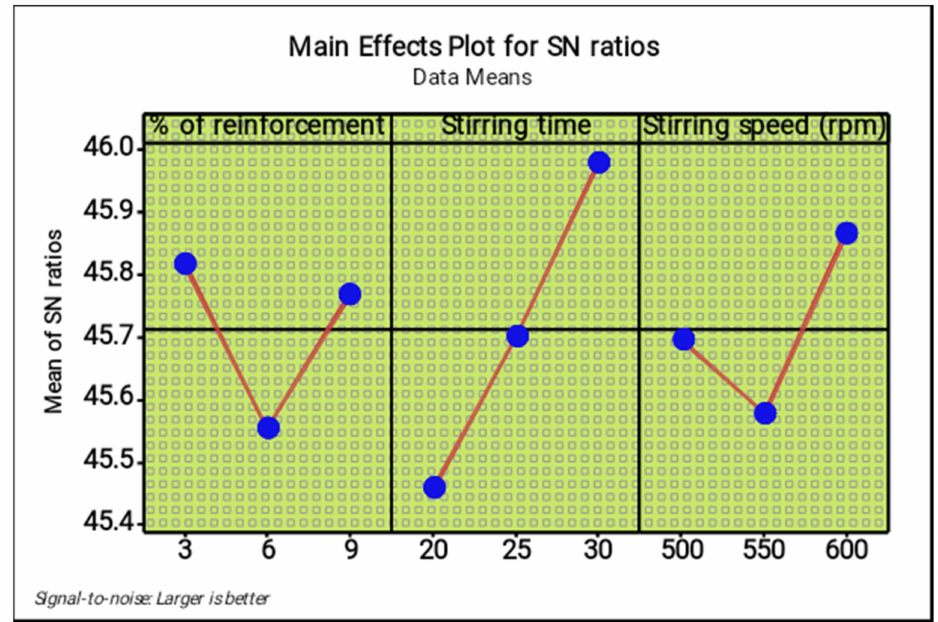
Figure 8. Main effect plot for S/N ratios (ultimate tensile strength). The four in one plots (Figure 9), such as the residual plot, indicated which parameters are to be highly involved to produce the maximum tensile strength. In a normal probability plot, most of the points are lying on the mean line and few of them close to the mean line; thereby, it is observed that the chosen parameters are excellent and that the ultimate tensile strength was accurate. In the versus fits plot, the nine points are distributed in a normal condition and the distribution values are lying within the limit. The histogram plots versus the order plots provided the accurate results of the ultimate tensile strengths. The points were distributed in a rectangle form and the zigzag motions proved that the selection of parameters highly reflected the response values.